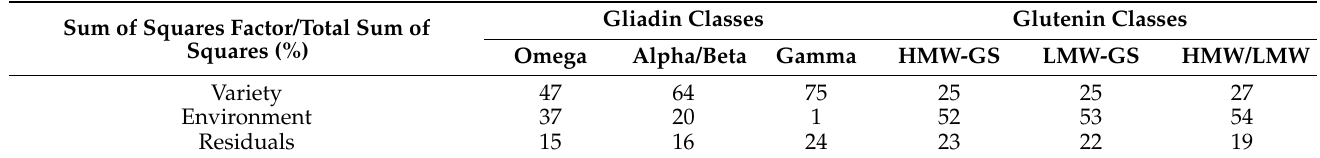
Table 5. Contribution (expressed in sum of squares values) of factors “variety” and “environment” to the variability of the studied